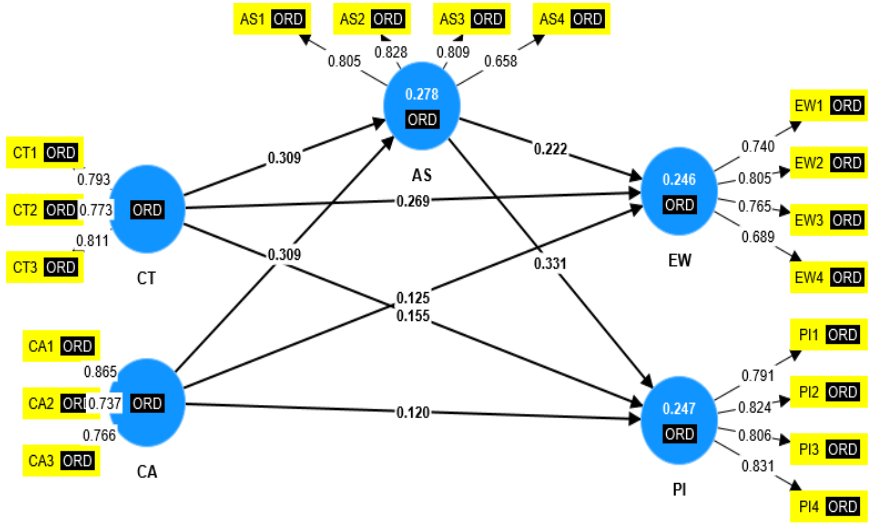
Figure 2. The measurement model estimate with beta values.